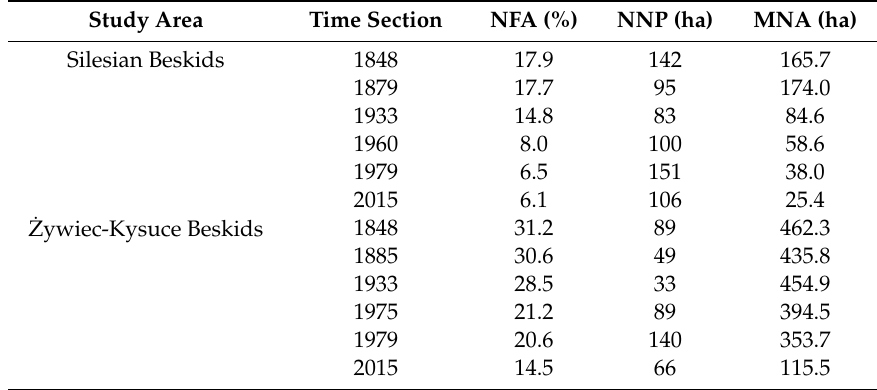
Table 3. Changes in non-forest area: NFA—percentage of non-forest area, NNP—number of non-forest patches, MNA—maximal non-forest patches